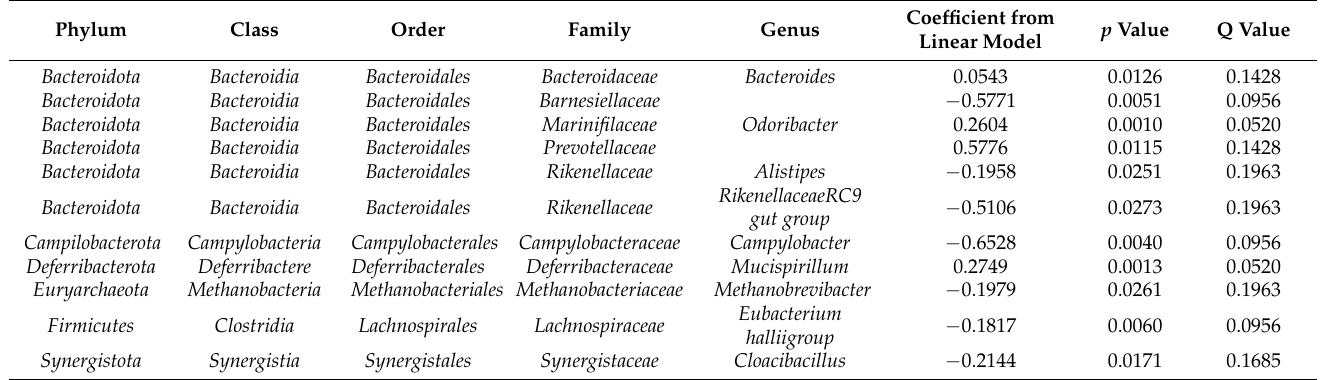
Table 3. Differentially abundant taxa in the cecal microbiota from birds fed a pine needle extract- supplemented